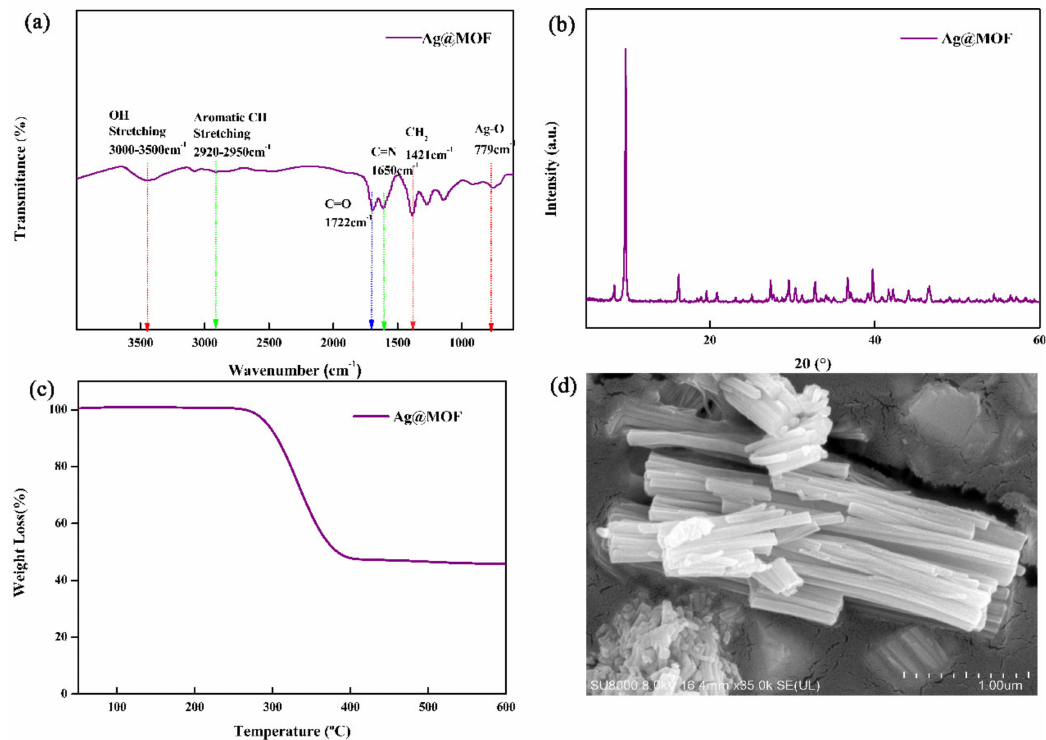
Figure 2. ( a ) FTIR spectra, ( b ) XRD pattern, ( c ) TGA curve and ( d ) SEM image of